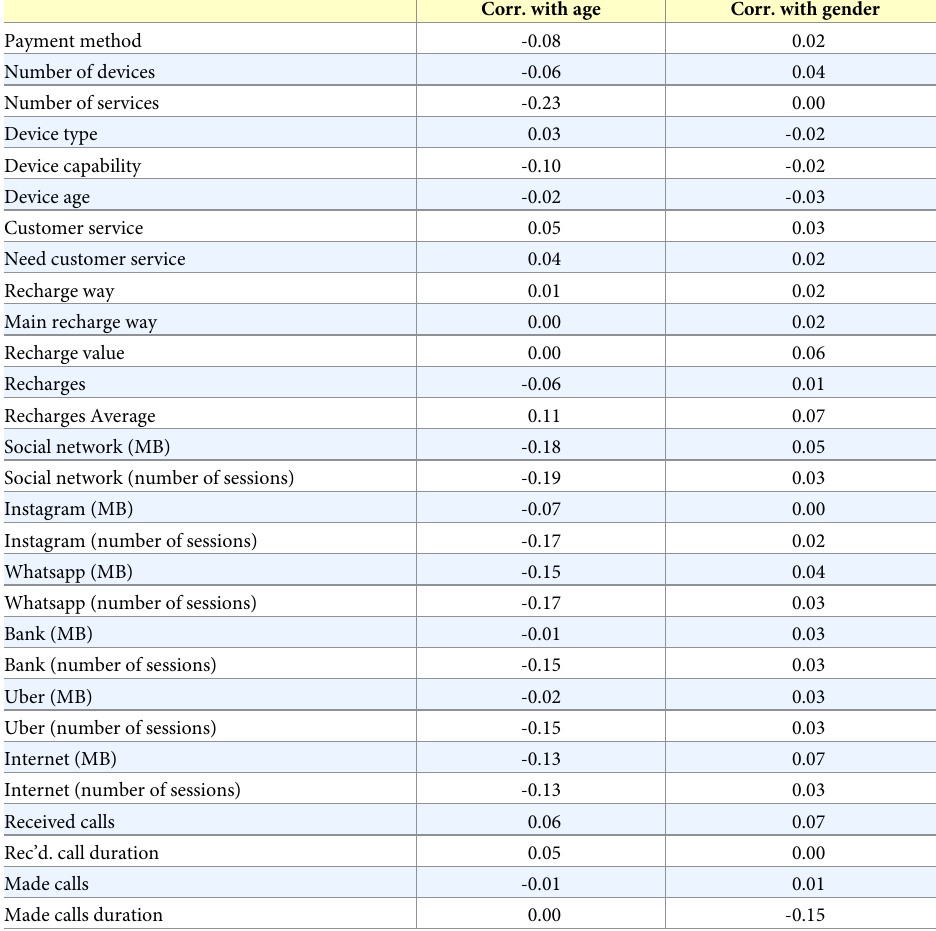
Table 2. Response variable correlations. (For gender, Male = 1, Female = 0). Corr. with age Corr. with